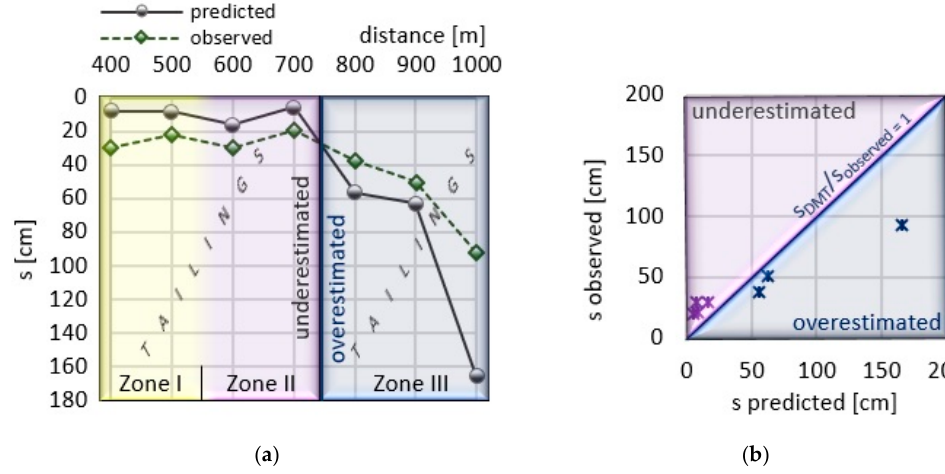
Figure 7. ( a ) Predicted and observed settlements comparison; ( b ) settlements agreement of tailings.